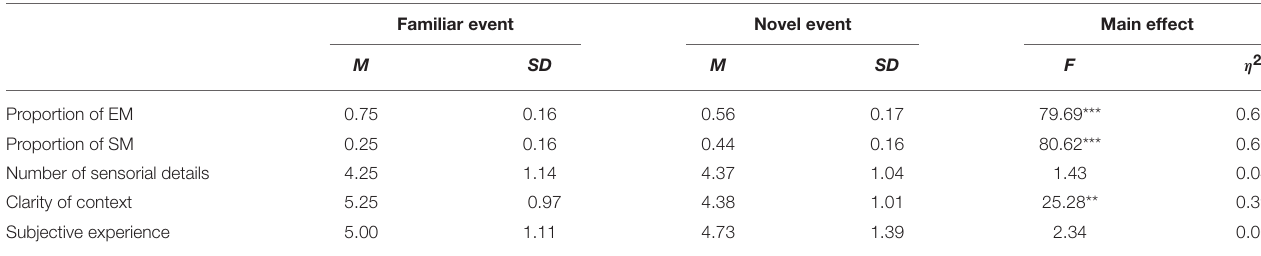
TABLE 1 | Characteristics of familiar versus novel event